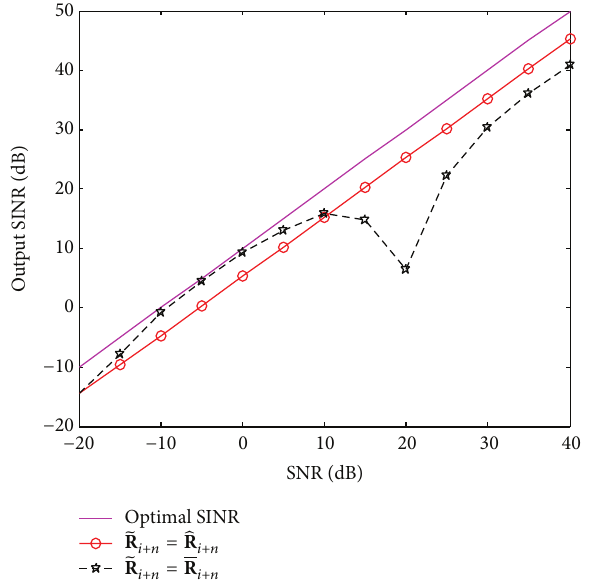
Figure 14: Values of 𝛼 and 1 − 𝛼 versus the SNRs.